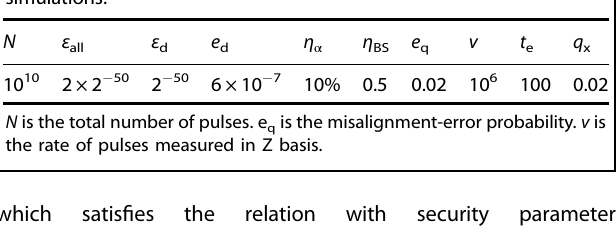
which satis fi es the relation with security